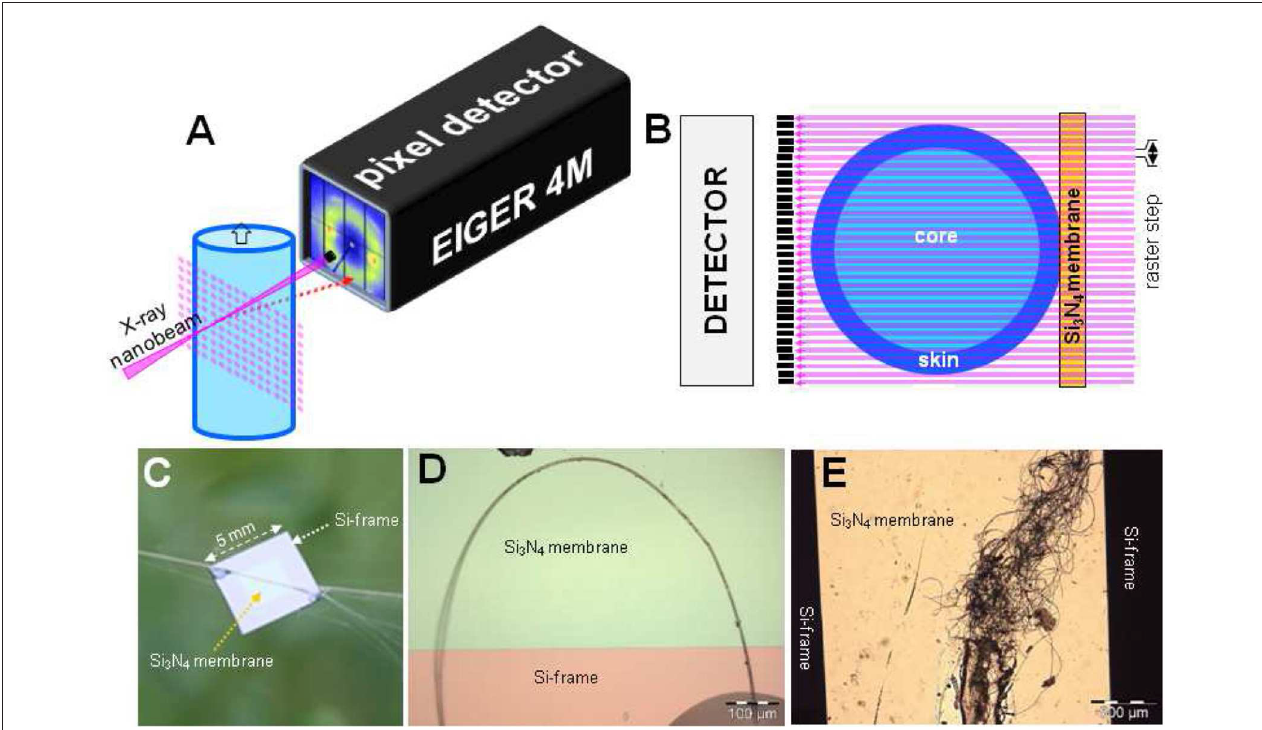
FIGURE 1 | Methodological aspects of scanning nanoXRD. (A) Mesh-scan of fiber through X-ray focal spot. Diffraction patterns are recorded at each step. (B) View normal to beam direction of mesh-scan through fiber section with skin-core morphology. The depth-of-focus guarantees a quasi-constant spot diameter across the fiber. (C) A. bruennichi’s bridge-thread bundle glued to Si 3 N 4 membrane supported by a Si-frame; (D) Bridge-thread bent into a loop for probing local deformation (not reported below). (E) Decorating fibers from A. bruennichi’s stabilimentum. (B,C) Reproduced/adapted from Riekel et al. (2017) with permission from